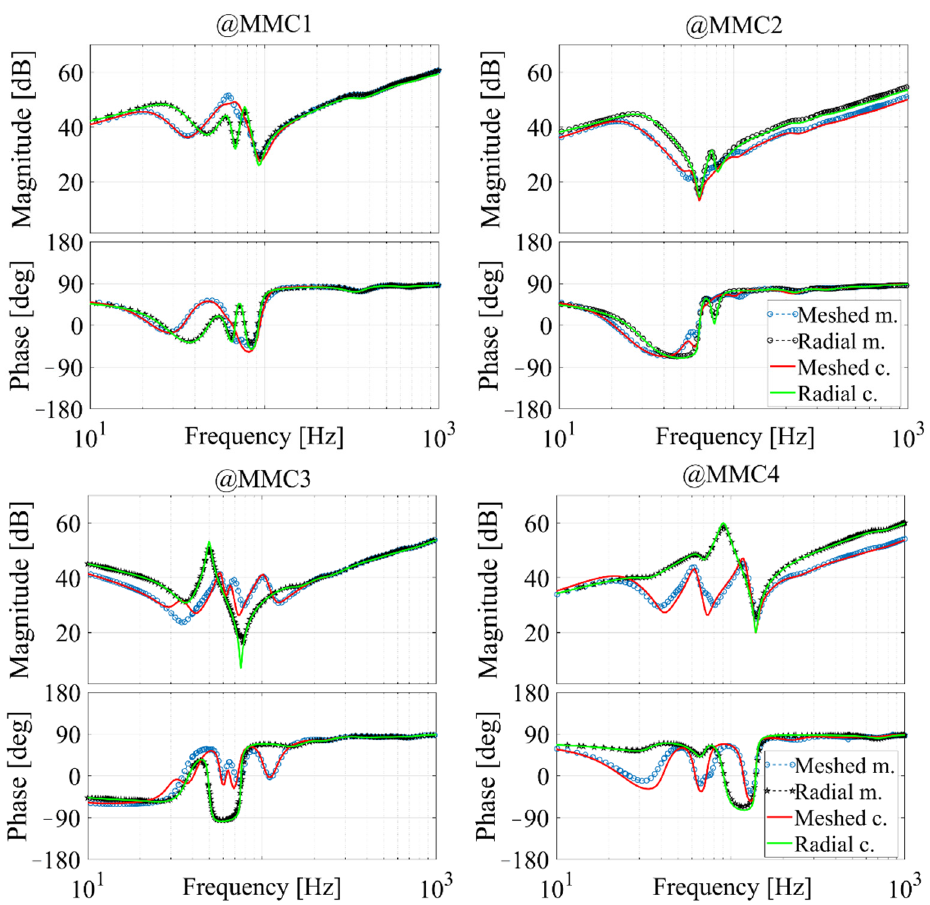
Figure 11. Measured vs. calculated radial (black vs. green) and meshed (blue vs. red) network equivalent impedance seen from the four different MMCs.